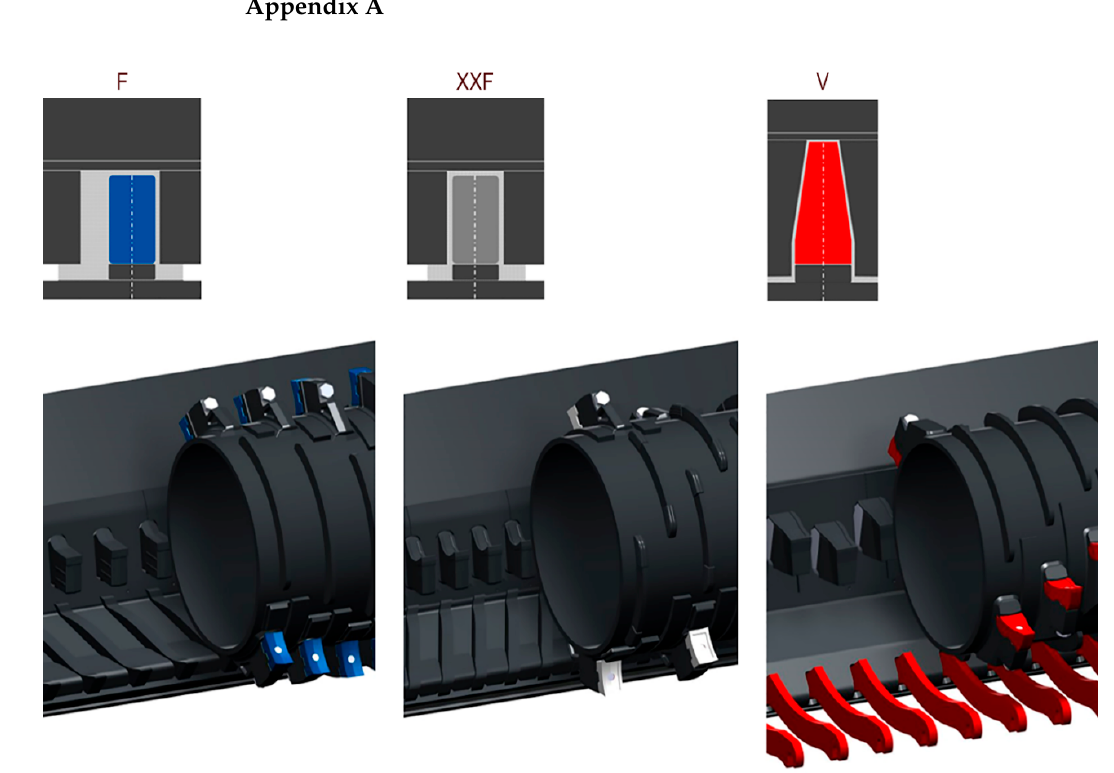
Figure A1. Cutting tool geometries [24]. Table A1. Technical data of the cutting tool geometries [24].